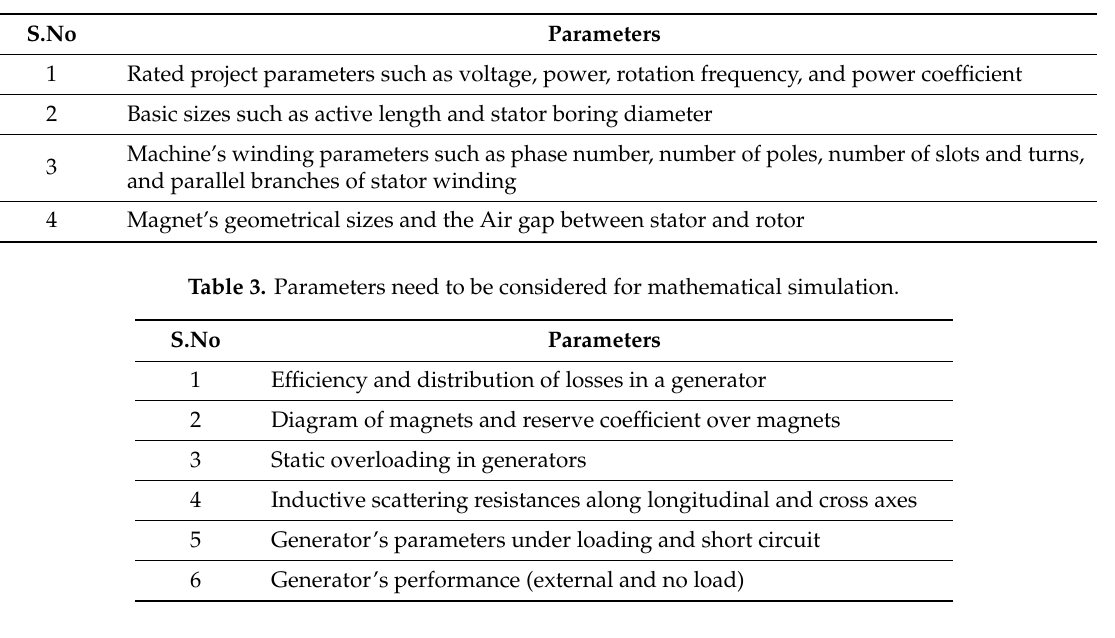
Table 2. Parameters need to be considered for acquiring synchronous machines [43].